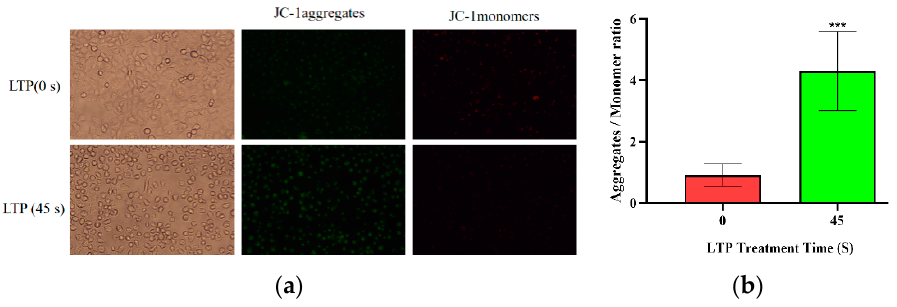
Figure 5. LTP resulted in depolarization of the mitochondrial membrane potential of CALU-1 cells. ( a ) Fluorescence microscope was performed to detect JC-1 monomers and aggregates and ( b ) the data were quantitated and graphed (paired-samples t test). *** p < 0.001; compared with the 0 s LTP treatment group.